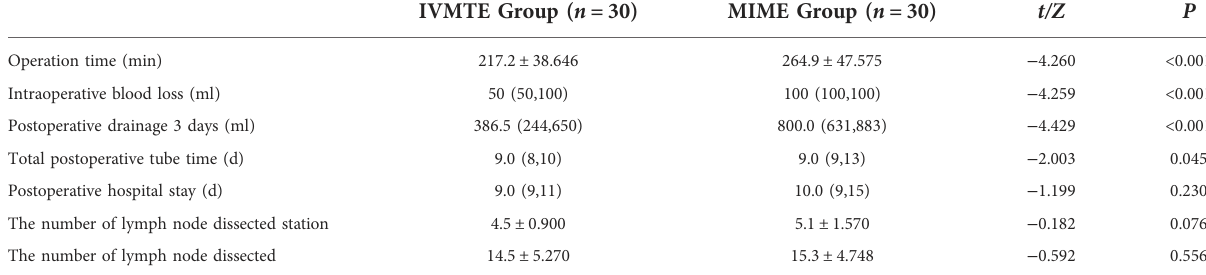
TABLE 2 Comparisons of perioperative data between the two groups.